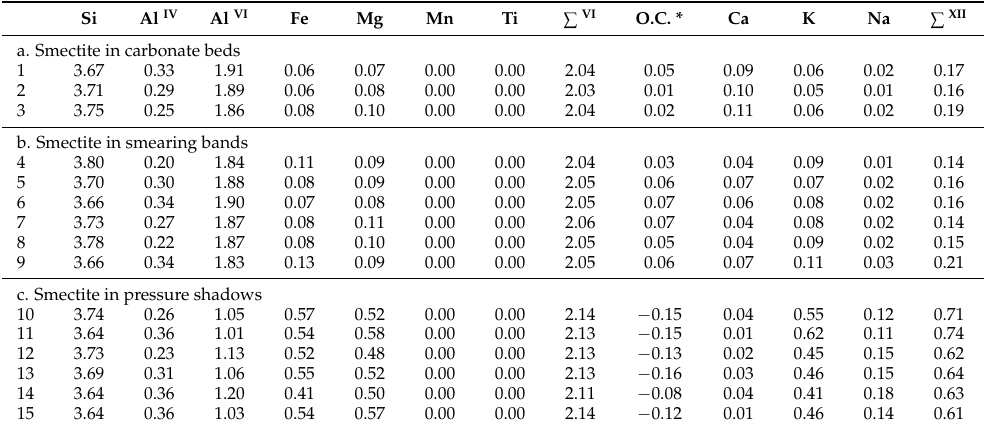
Figure 5. SE image of a carbonate sample from the trench. Dol: dolomite, Sm: smectite. Table 1. AEM data of smectites normalized to O 10 (OH) 2 .